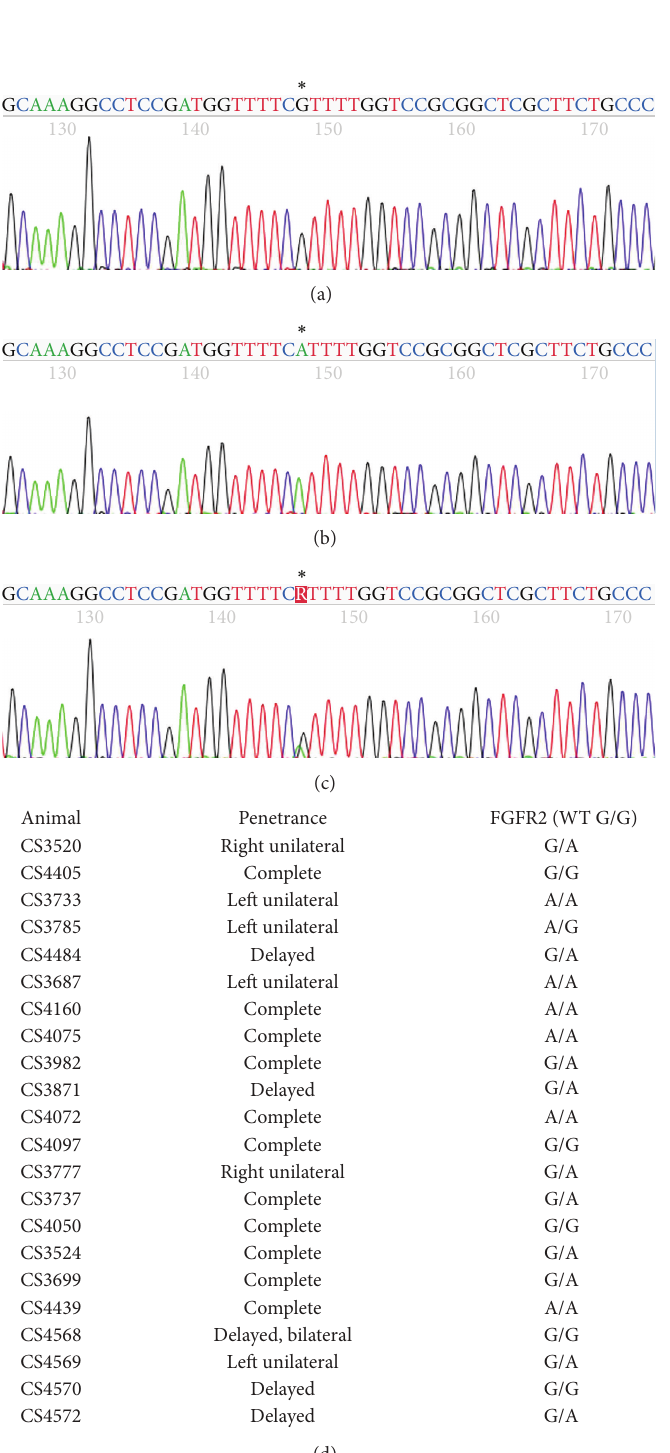
Figure 4: SNP discovery and genotyping of FGFR2 in craniosynostotic rabbits . We identified a FGFR2 SNP within exon 9, a silent mutation, that segregates independently of craniosynostosis within our colony, ruling out FGFR2 as the causative agent. ((a)–(c)) Sequencing traces representing G/G (a), A/A (b), or G/A (c) genotypes from CS genomic DNA. (d) Results of sequencing of 22 randomly selected CS animals; five animals were G/G genotype, seven animals were A/A, and ten animals were